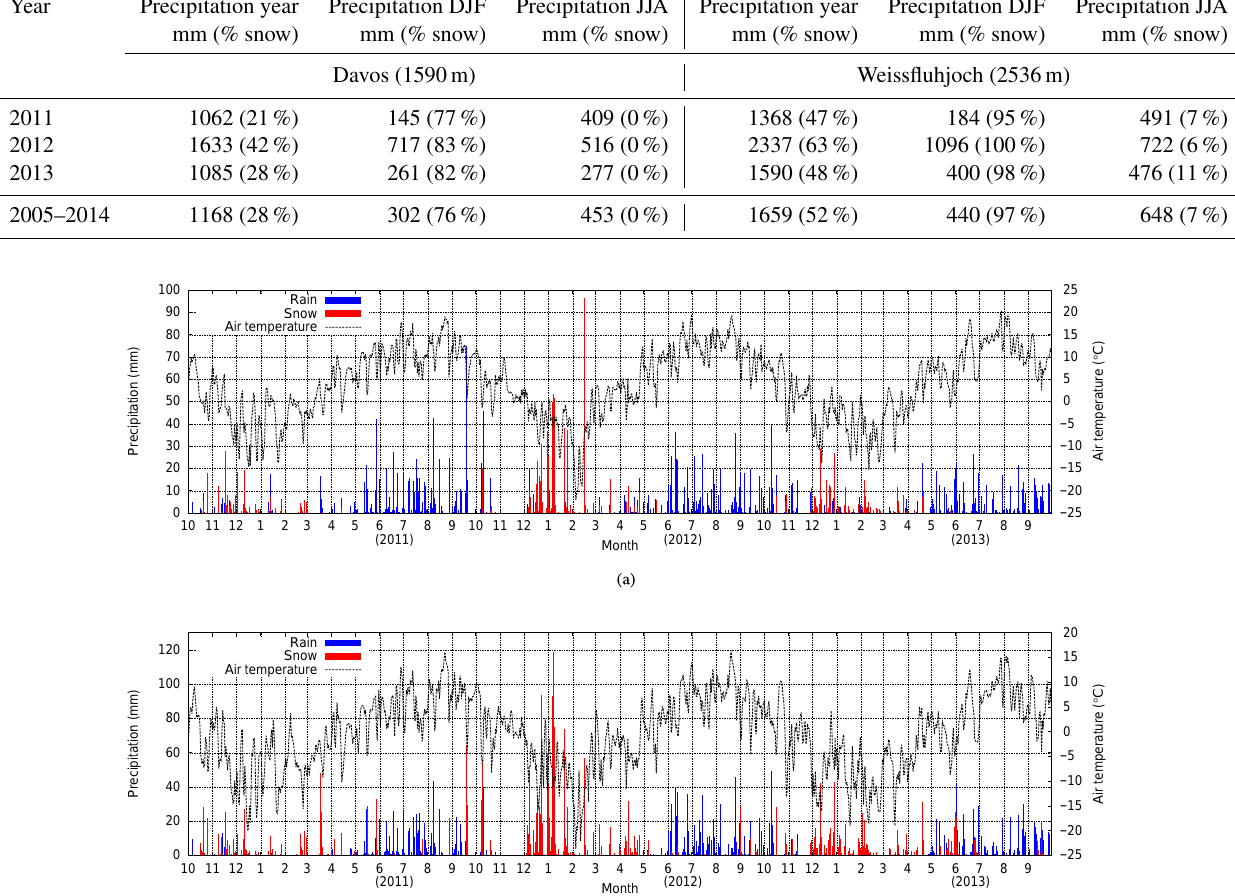
Table 1. Yearly, winter months (DJF) and summer months (JJA) precipitation sums from heated rain gauges in the area around Davos. In brackets is the percentage that falls as snow, based on measured air temperature below 1.2 ◦ C calculated with half-hourly measurements. The last line lists the average over the 10-year period (2005–2014).